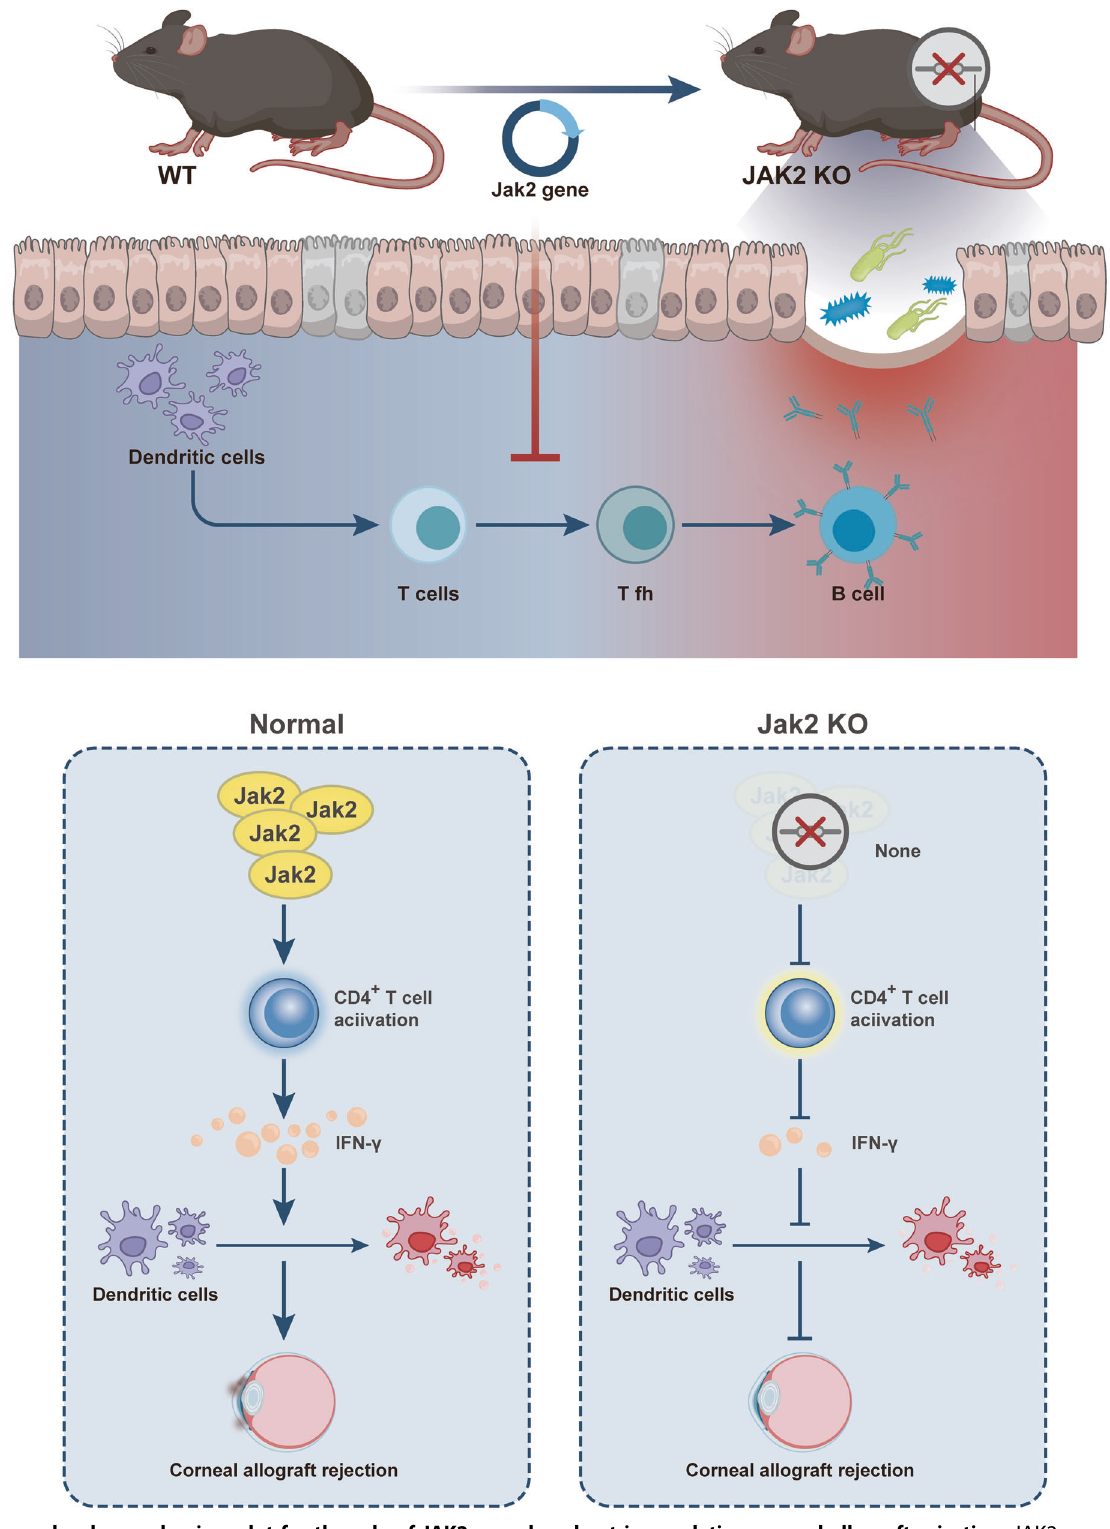
Fig. 5 The molecular mechanism plot for the role of JAK2 gene knockout in regulating corneal allograft rejection. JAK2 gene knockout contributes to inactivation of CD4 + T cells to decrease IFN- γ expression and suppress DC development, maturation and secretion of in fl ammatory cytokines, which leads to inhibition of corneal allograft Intervention of JAK2 knockout mice pathogen-free grade). The right eyes of the recipient mice were used as the operated eyes, and for the donor mice, both eyes were used. In the The study enrolled 18 JAK2 knockout mice (C57BL/6 strain; 6 – 8 weeks old, wild-type (WT) group, BALB/c mice were used as donors; the C57BL/6 mice speci fi c-pathogen-free grade) and 18 BALB/c mice (6 – 8 weeks old, speci fi c-